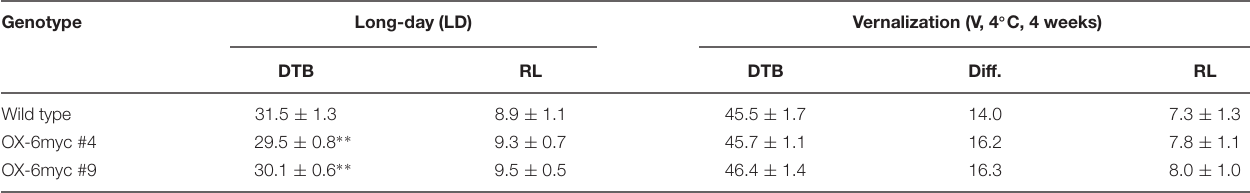
TABLE 1 | Flowering phenotypes of DnAGL19 overexpressing Arabidopsis thaliana.